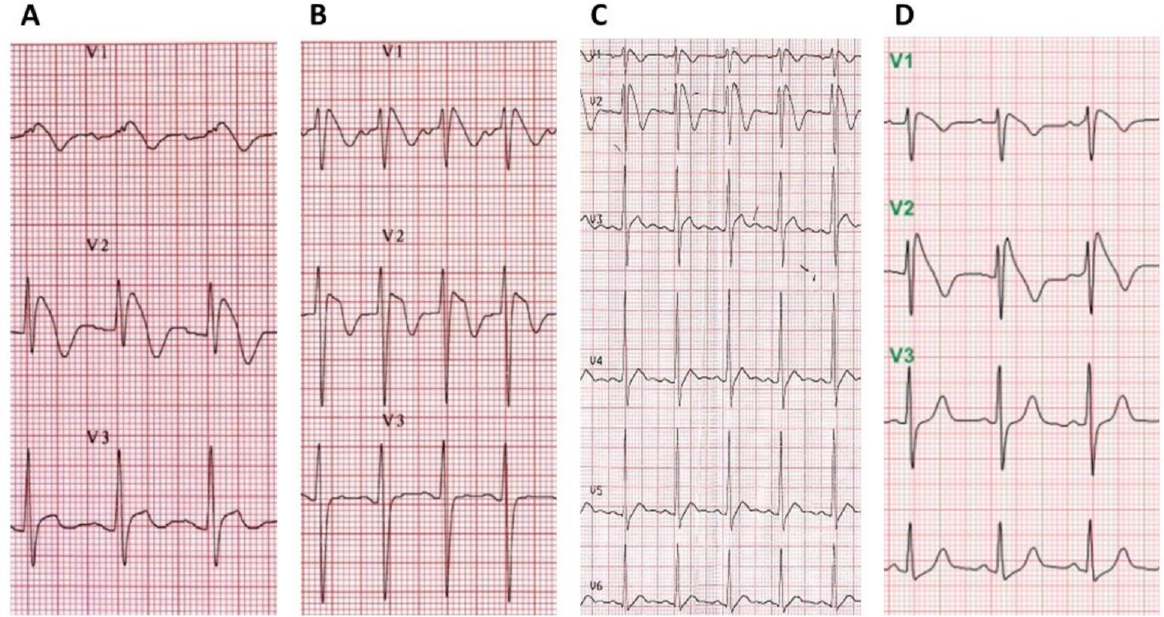
Figure 2. Fever-induced Brugada ECG pattern in different clinical situations. Typical Brugada ECG pattern during the febrile state is evident in different conditions: ( A ) acute tonsilitis in a 25-year-old man (temperature, 39 ◦ C); ( B ) heatstroke in a 24-year-old man (temperature, 41 ◦ C); ( C ) phenytoin-induced Stevens–Johnson disease in a 29-year-old man (temperature, 39.4 ◦ C); ( D ) carbon monoxide intoxication in a 25-year-old female patient (temperature, 38 ◦